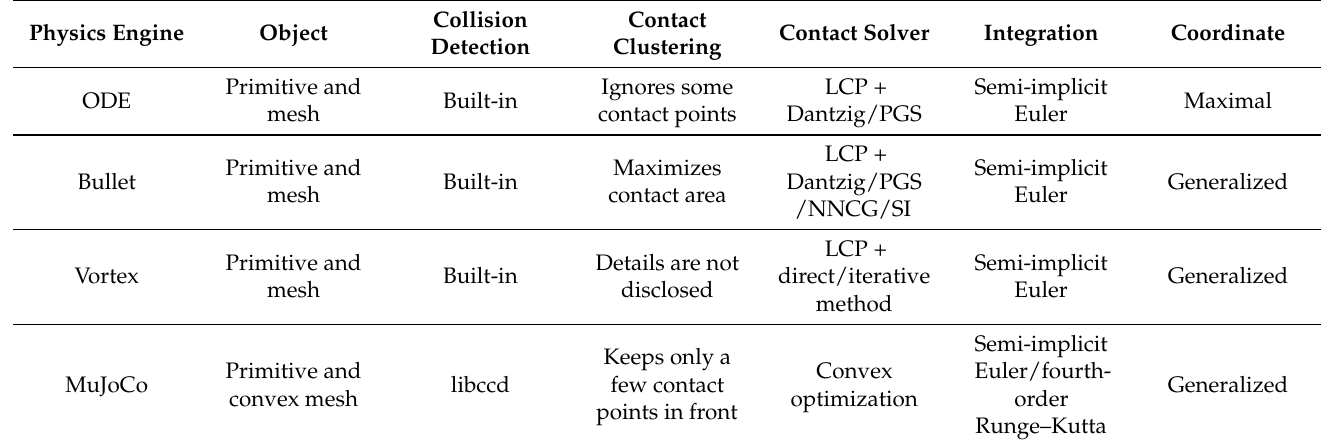
Table 1. Comparison of physics